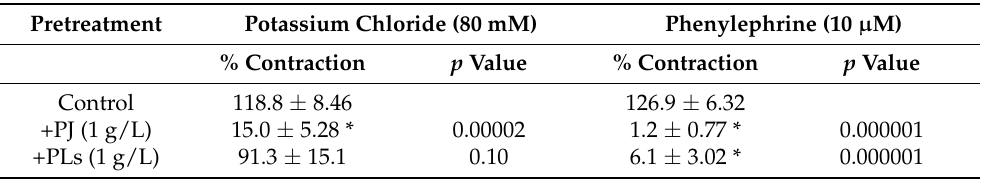
of Ca 2+ , i.e., with inhibition of the influx of extracellular Ca 2+ through the receptor-operated Ca 2+ channels (ROCs), was significantly inhibited by pretreatment with PJ powder. In